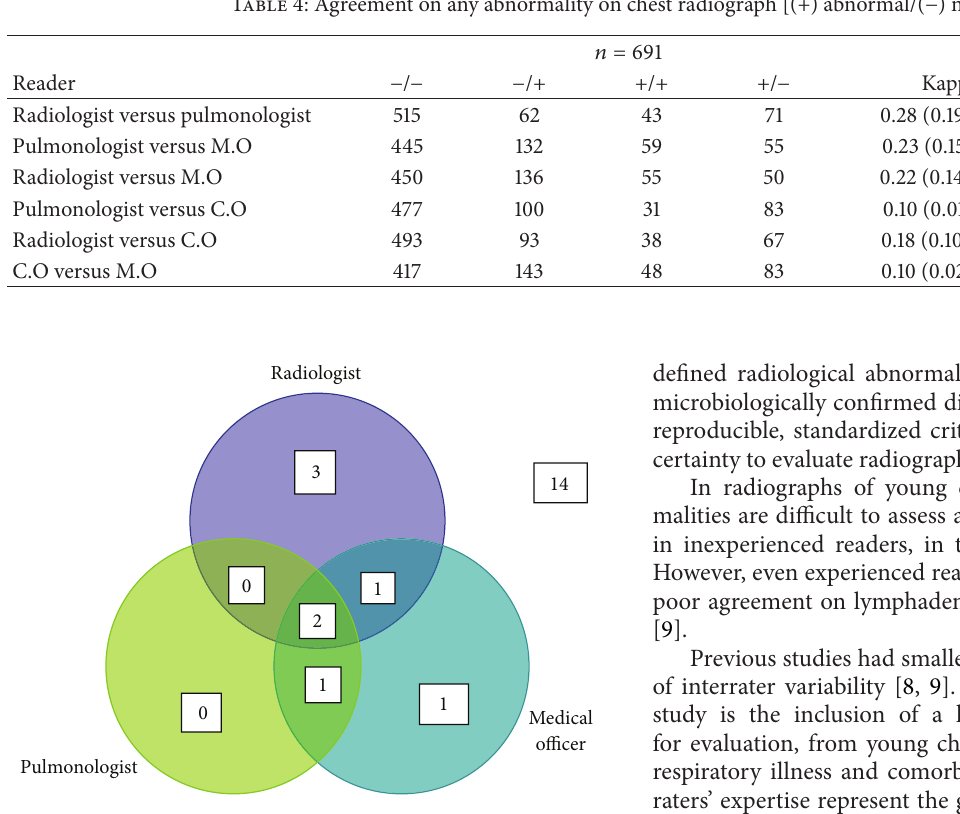
Figure 2: Venn diagram showing radiographs of probable TB cases reviewed by all raters ( 𝑛 = 28 ) and classified as “abnormal likely